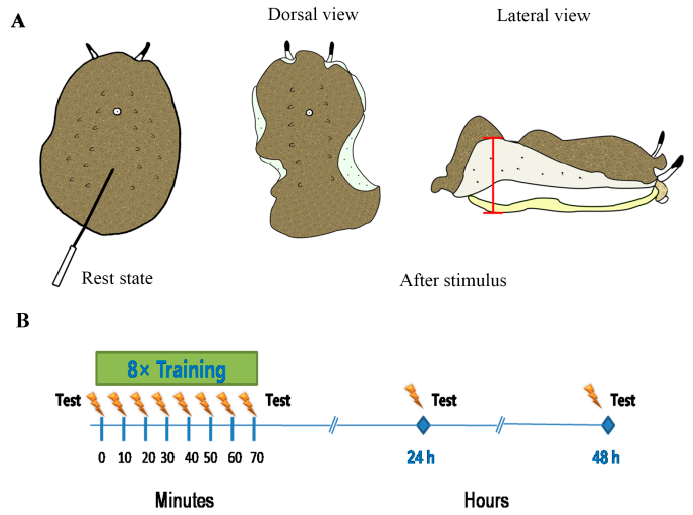
Figure 2: The mantle-upturned reflex training of Onchidium reevesii and experimental protocol for each animal. ( A ) Mantle-upturned reflex (MUR) of O. reevesii . When animals received the stimulus in the notum, their mantle elevated, as shown in the dorsal view and lateral view. The red line segment is the MUR amplitude. ( B ) Experimental protocols. The timing of training and testing is shown at relative intervals. The duration of the first-time shock was seen as the test result in “before training”, and the duration of the last shock in “8x training” was seen as the test result of acquisition. After 24 h and 48 h, consolidation testing was performed using one shock. The experimental lighting conditions depended on the cycles that those animals